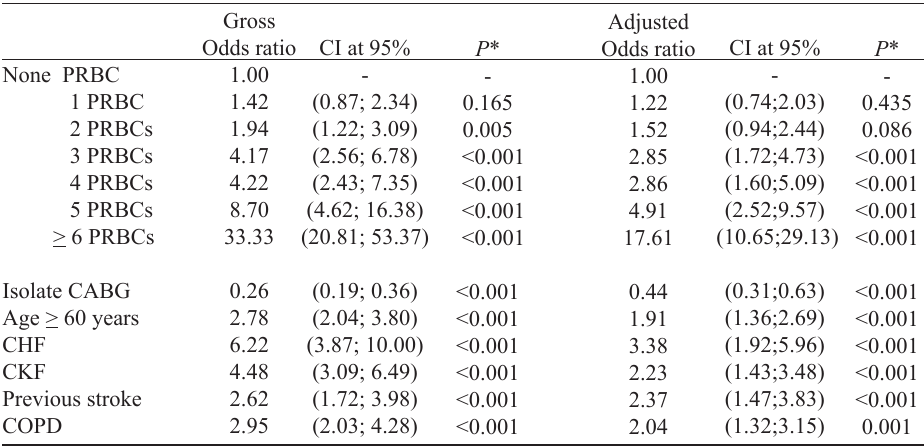
Table 3. Gross and adjusted odds ratio values for mortality